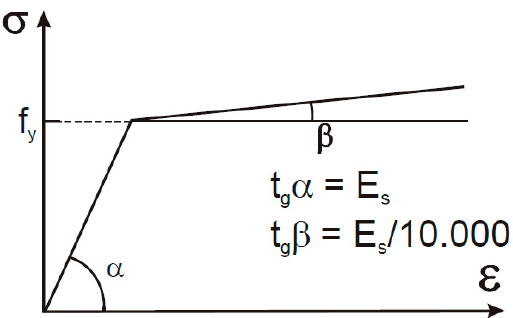
Figure 10. Stress–strain bilinear diagram, with second branch inclined for nonlinear calculations [31].